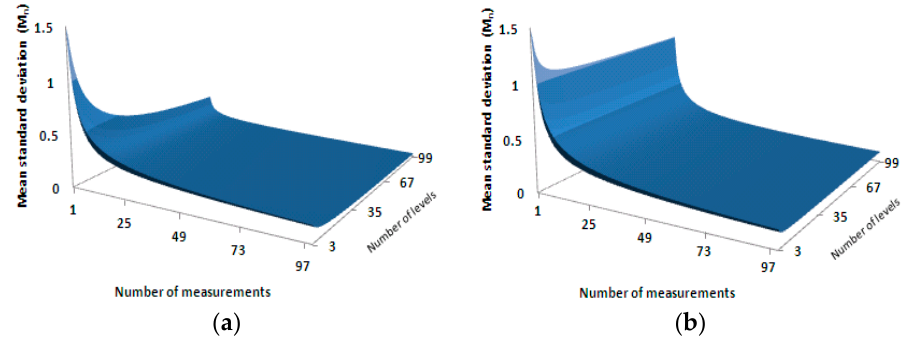
Figure 2. The relationship between the precision and the two parameters, the number of the radiance level and the number of measurements. The horizontal axes are the number of measurements and the number of radiance level, respectively, and the vertical axis is the precision (mean standard deviation) of the calibration result. ( a ) relationship surface with four evenly-divided groups; ( b ) relationship surface without grouping.